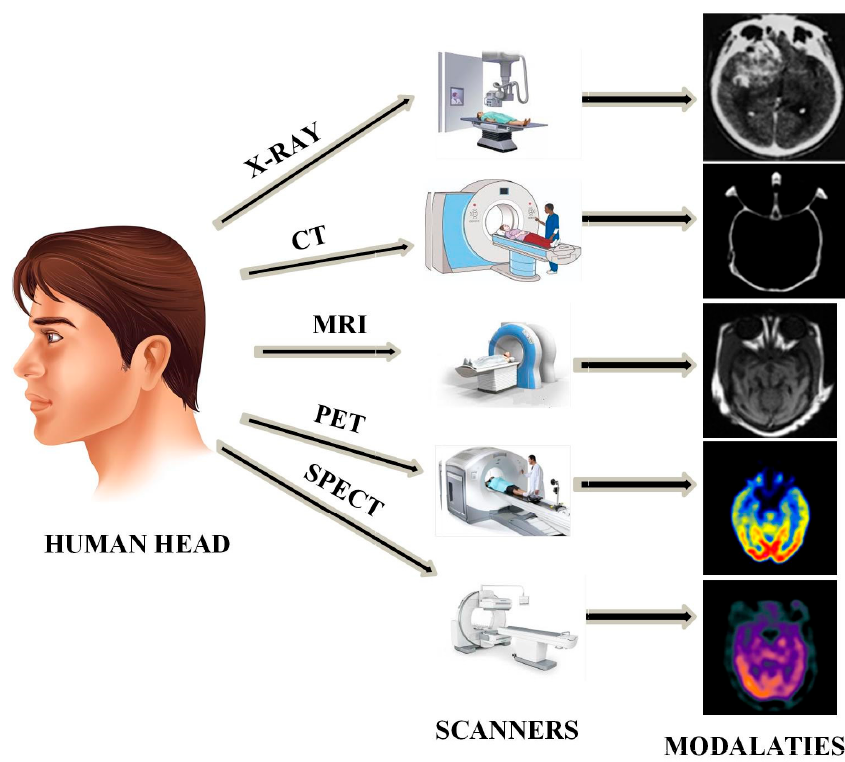
Figure 1. Illustration of the classification of different medical brain imaging modalities.